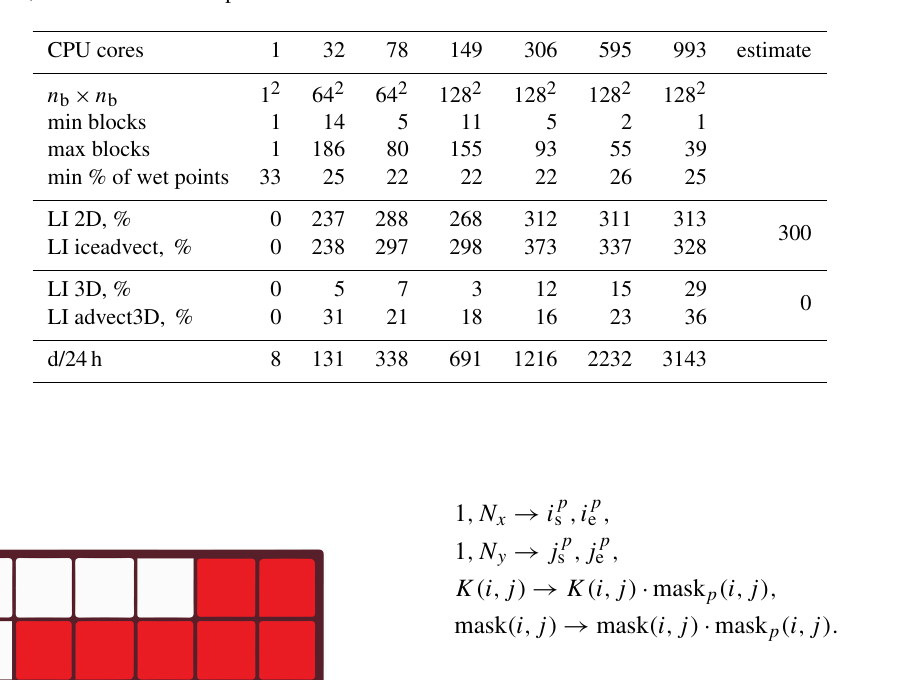
Table 3. Same as Table 2, but for the hilbert3d partition.